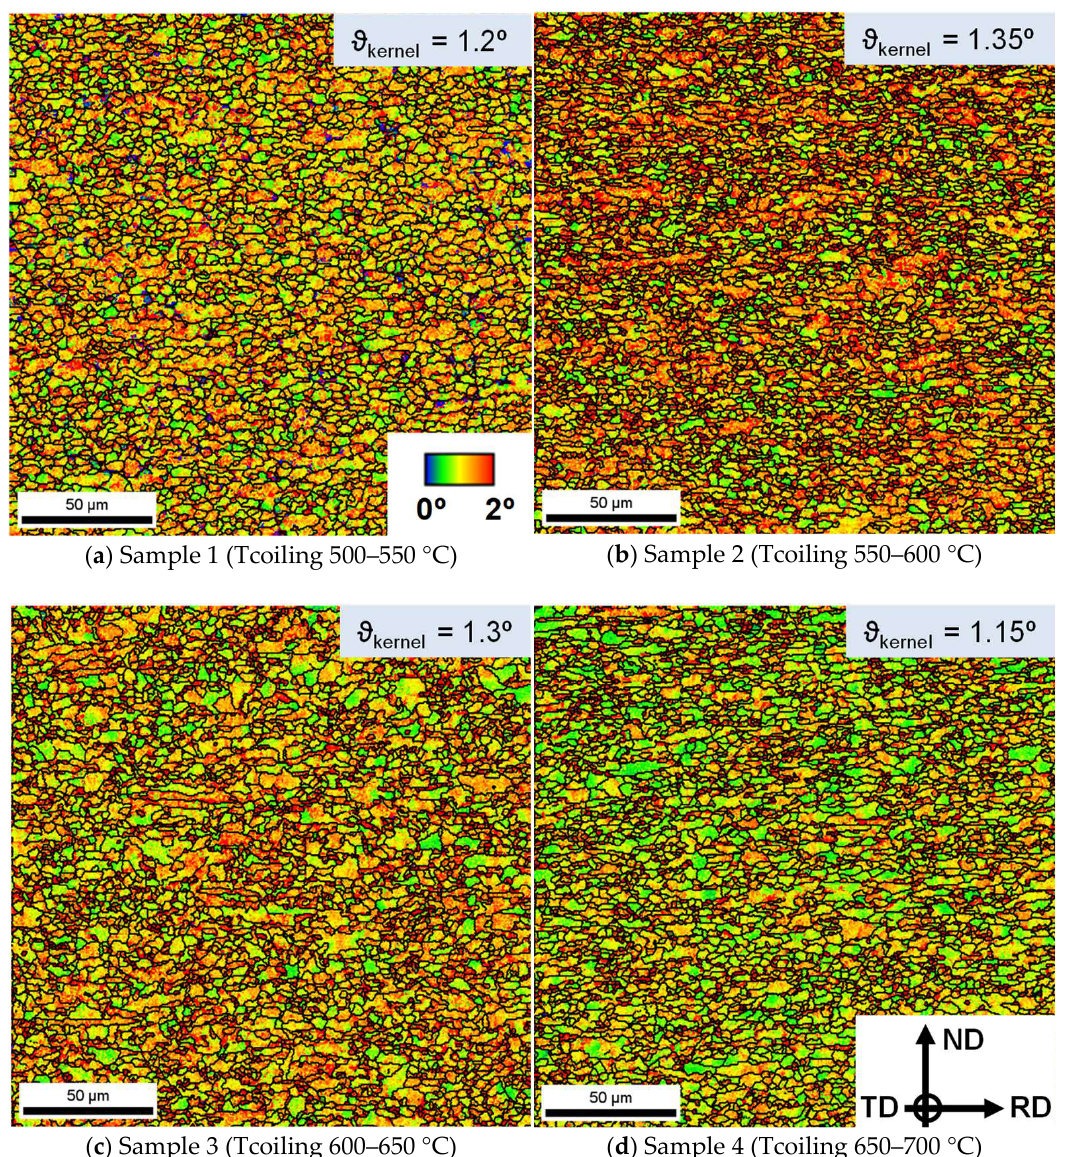
Figure 9. Kernel maps corresponding to the different coiling temperatures: ( a ) Sample 1 (Tcoiling 500–550 °C), ( b ) Sample 2 (Tcoiling 550–600 °C), ( c ) Sample 3 (Tcoiling 600–650 °C), ( d ) Sample 4 (Tcoiling 650–700 °C).